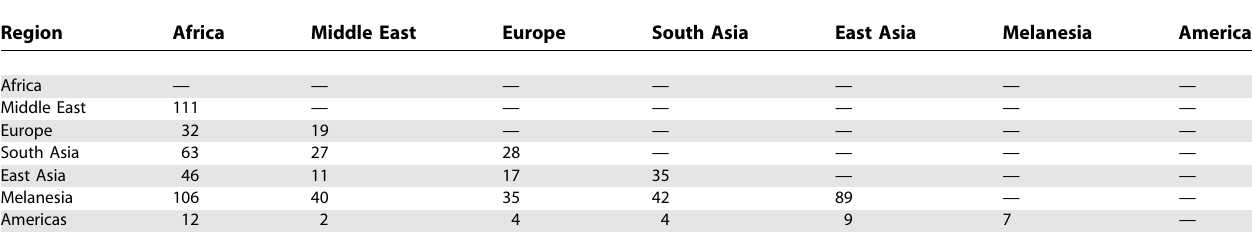
Table 4. Bi-Continental Allele Sharing